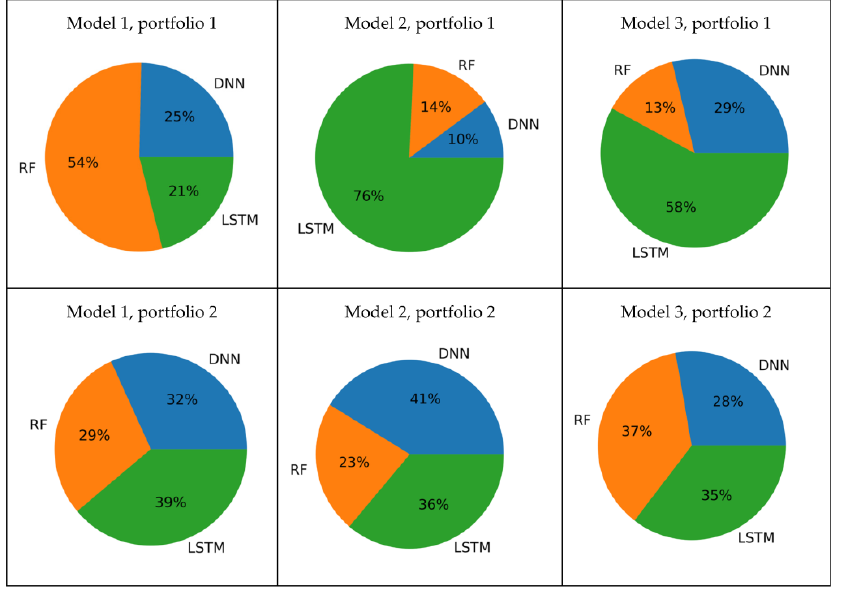
Figure 8. Portfolio structure depending on the technique of their construction. Portfolio structure is the same for the training and test sets.